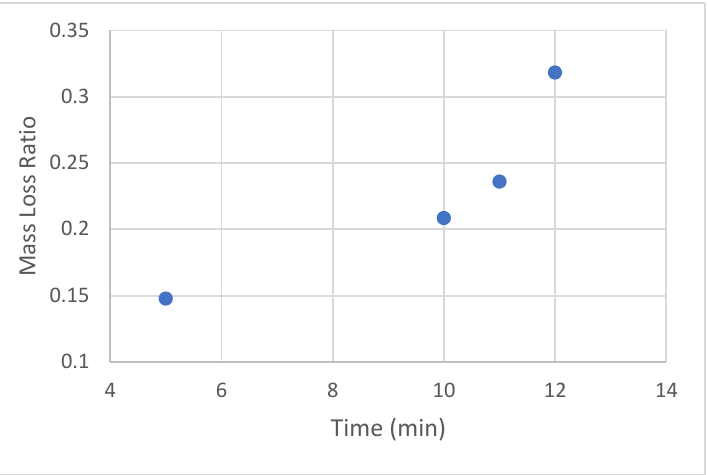
Figure 11. MLR for 124 kGy resins held at 193 °C (380 °F) for various time durations under 6672 N (1500 lbF) [data obtained with single samples at each hold time].